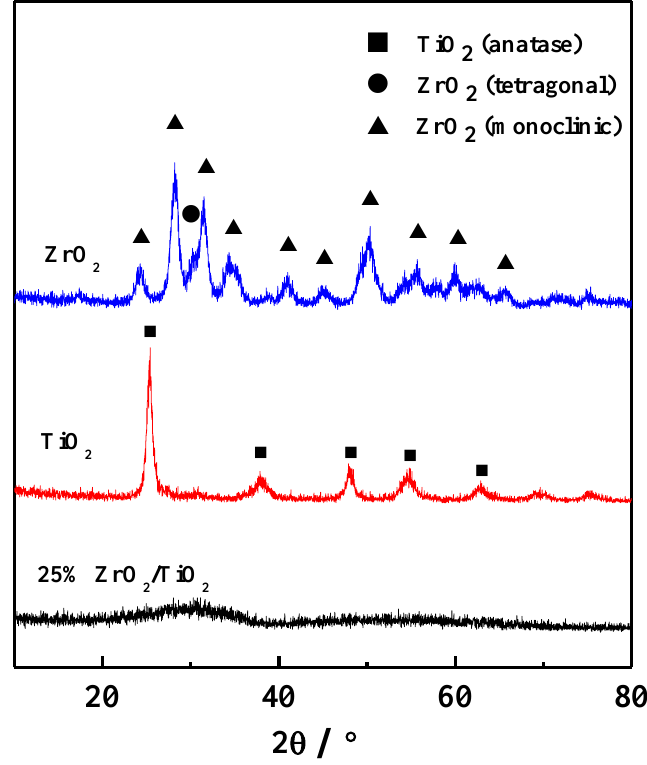
Figure 1. XRD patterns of samples. The TEM images of TiO 2 , ZrO 2 and 25%ZrO 2 /TiO 2 samples are showed in Figure 2a – c. Both TiO 2 and ZrO 2 are mainly accumulated large grains with regular particle shape, and the composite oxide 25%ZrO 2 /TiO 2 represents an aggregated form with high heap density particles, which are different from TiO 2 and ZrO 2 .